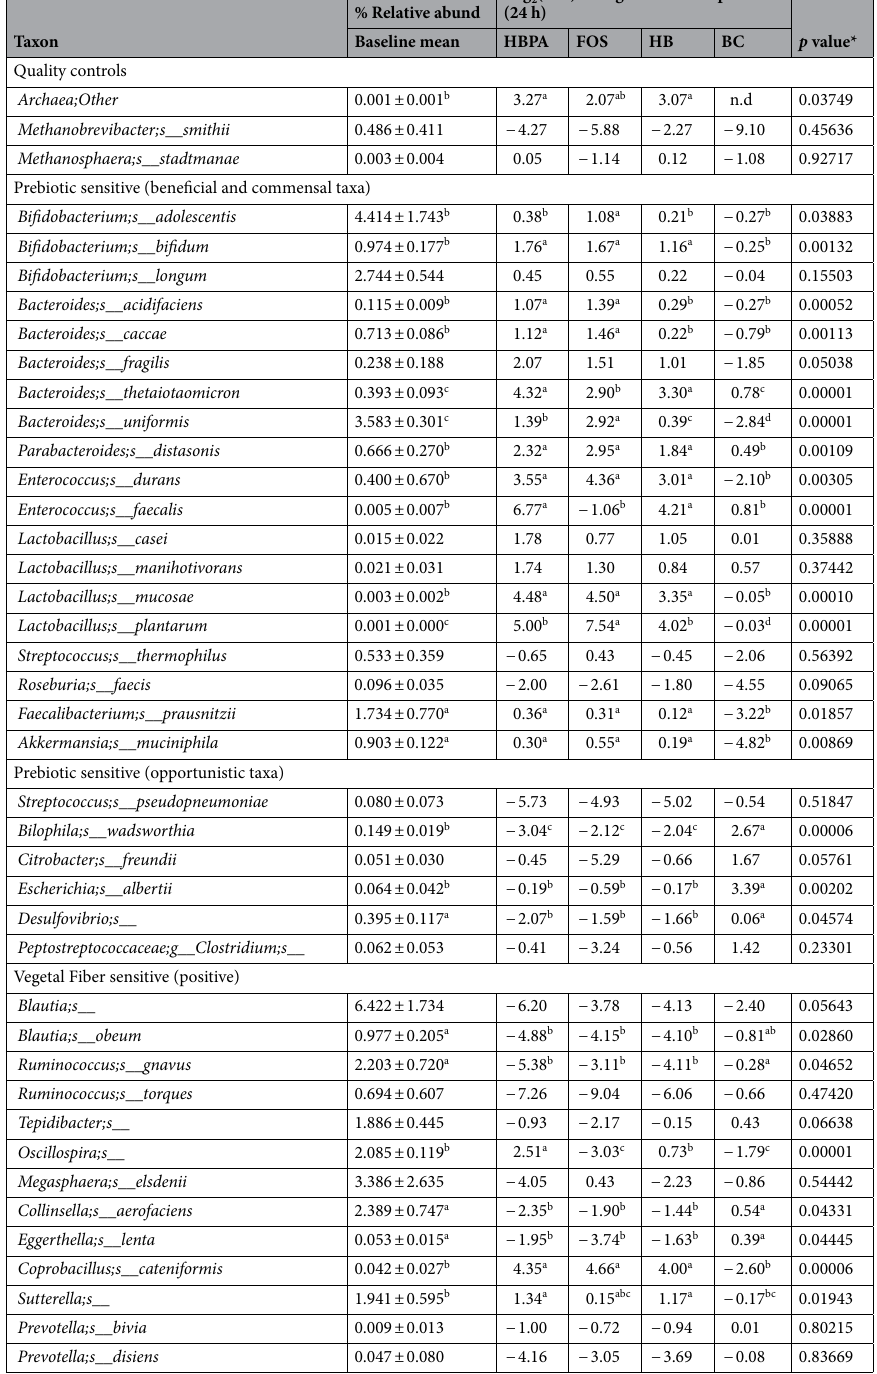
Table 1. Abundances (% ± S.D.) and changes in phylum taxa (Log 2 F/C) after 24 h in vitro fecal batch culture fermentations from healthy donors and administrated with HBPA, HB, and FOS as the substrates, and also including a blank control. HB Hempseed bran; HBPA HB protein extract hydrolyzed by alcalase; FOS fructooligosaccharides; BC Blank control. abc Letters indicate significant differences within a line by Tukey’s honestly significant differences (HSD) test ( p < 0.05). * p value indicates ANOVA test for groups